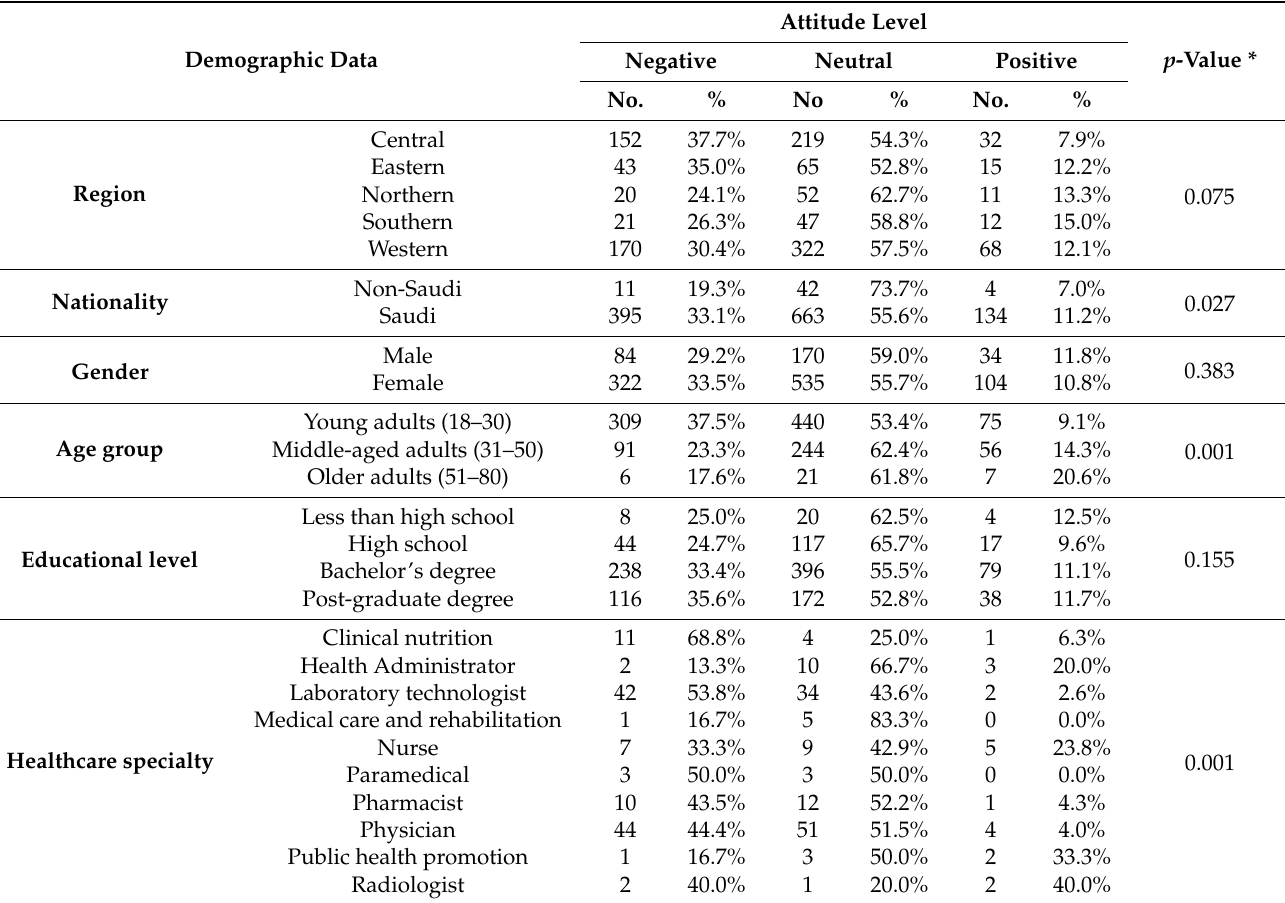
sociodemographic indicators is given on the adjacent column to their right, followed by the distribution according to attitudes towards medical misinformation. Table 2. Distribution of participants’ attitudes towards medical misinformation regarding the protective measures against COVID-19 infection in relation to their personal